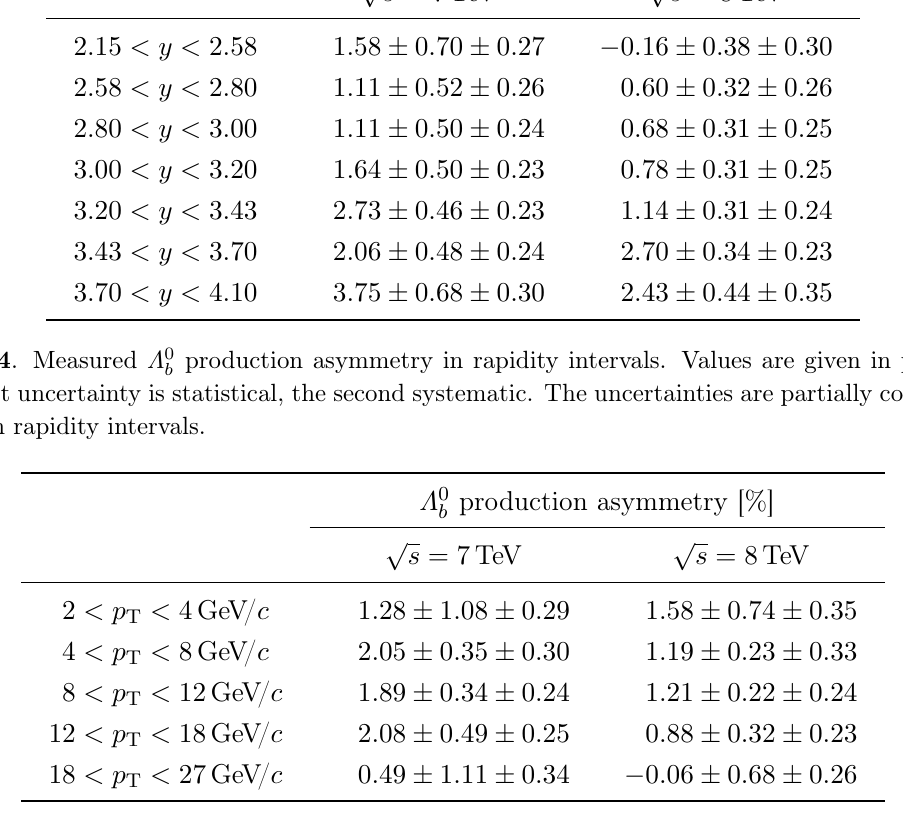
Table 5 . Measured (cid:3) 0 production asymmetry in intervals of transverse momentum. Asymmetry b values are given in percent. The first uncertainty is statistical, the second systematic. The uncer- tainties are partially correlated between transverse-momentum